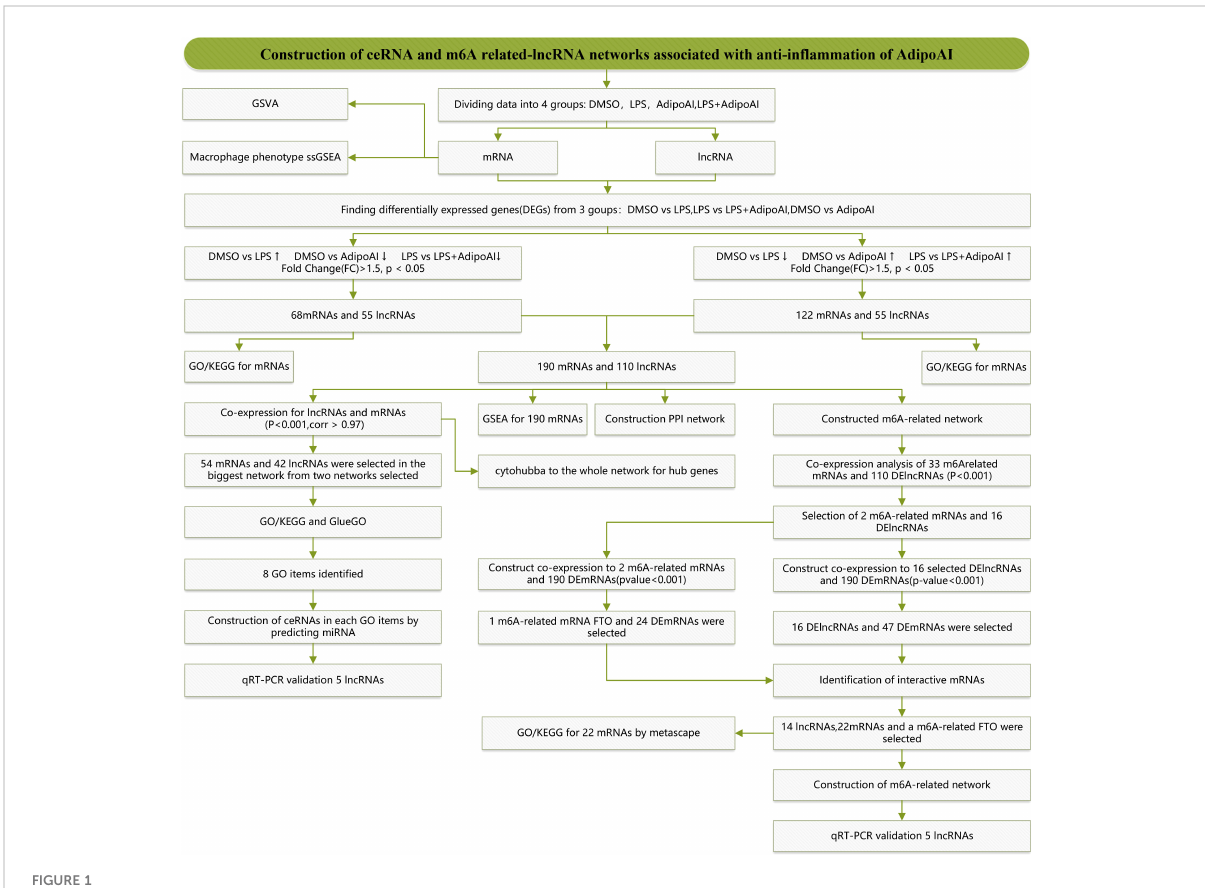
FIGURE 1 Study fl ow